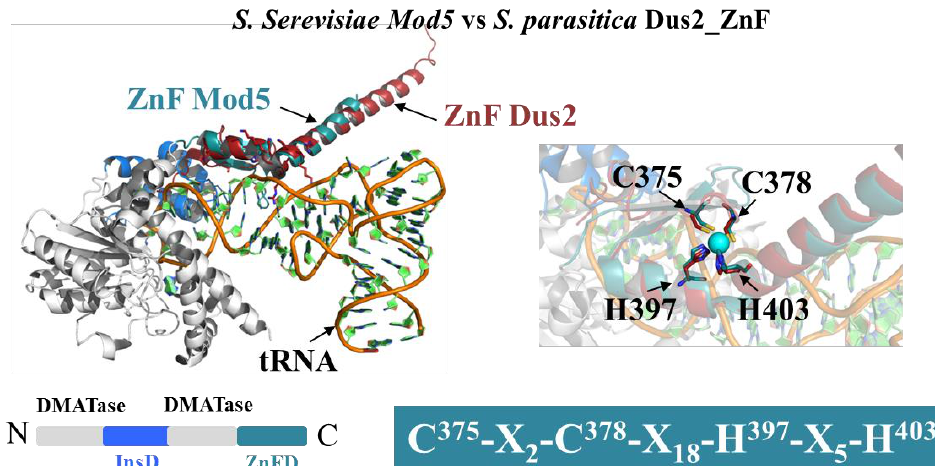
Figure 7. Structural comparison of the ZnFD of Dus2 and that of S. cerevisiae Mod5. ZnFD of S. parasitica Dus2 (in red) is superimposed on the ZnFD of Mod5 (in deep teal color) in the crystal structure of yeast Mod5/tRNACys (PDB: 3EPH). The below the figure is the schematic representation of the domain modularity of Mod5. The catalytic, inserted, and ZnFD of Mod5 are in gray, blue, and deep teal, respectively. A zoom of the superposition on the ZnF motif region is shown on the right. The ZnF motif of Mod5 is indicated below the zoom in the deep teal colored box.